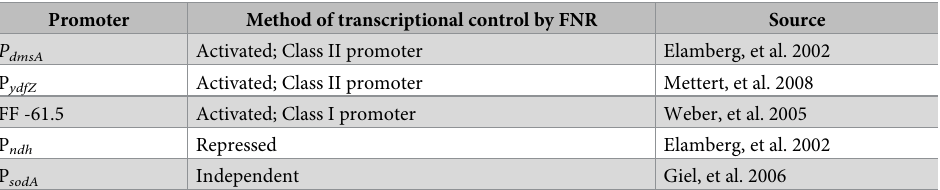
Table 1. Promoter- lacZ fusions used in this